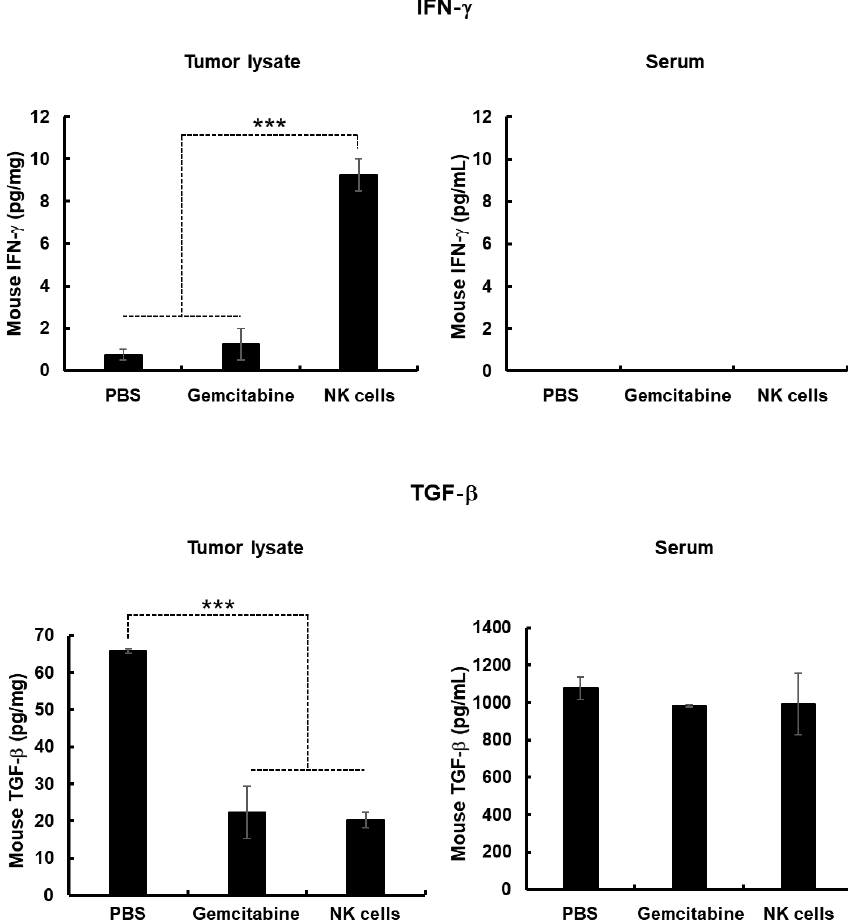
Figure 7. Expression of interferon (IFN)- γ and transforming growth factor (TGF)- β in tumor tissues and serum. Tumor tissues and serum were obtained at 3 days after final treatment with phosphate-bu ff ered saline (PBS), gemcitabine, or natural killer (NK) cell for quantitation of IFN- γ and TGF- β by conventional enzyme-linked immunosorbent assay (ELISA) kit. Data are presented as mean expression level ± standard deviation (SD) of triplicate experiments with at least three mice per group. *** p < 0.001.